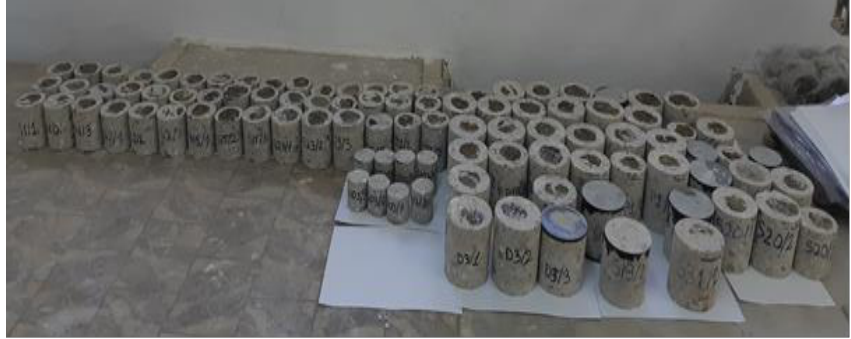
Figure 1. Concrete core specimens.